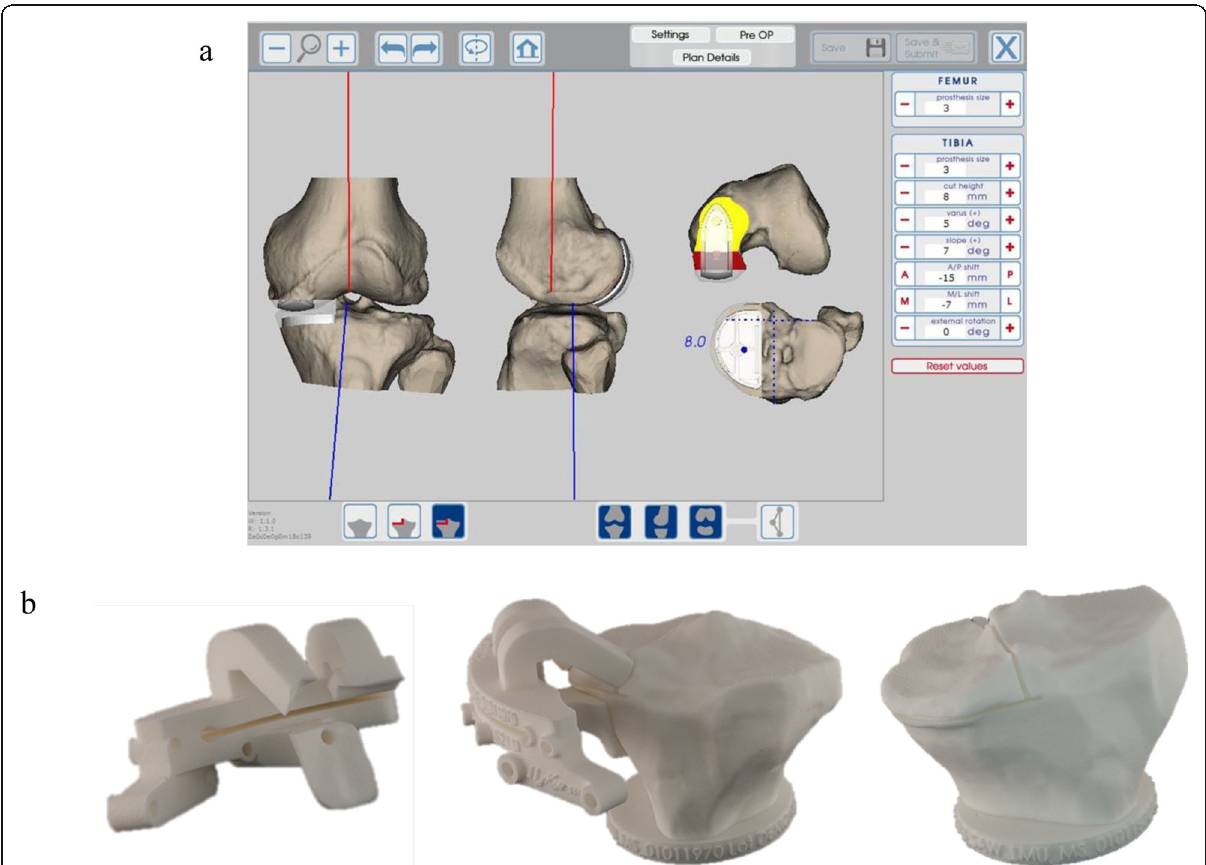
Fig. 1 Stages of the preoperative planning workflow. a) Design of the PSI guide. b) Verification of the PSI guide on 3Dprinted